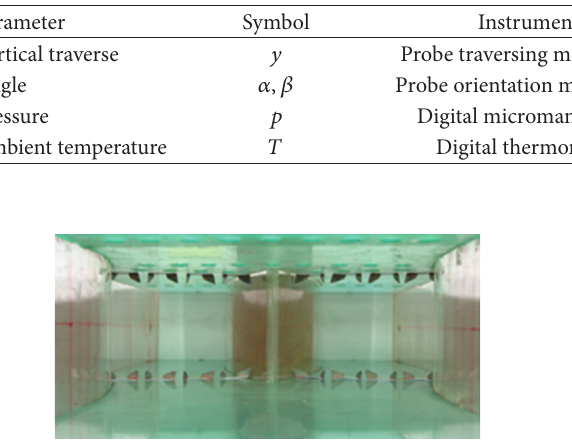
Figure 5: Location of VG (counterrotating) on the top-bottom walls of the air-intake.